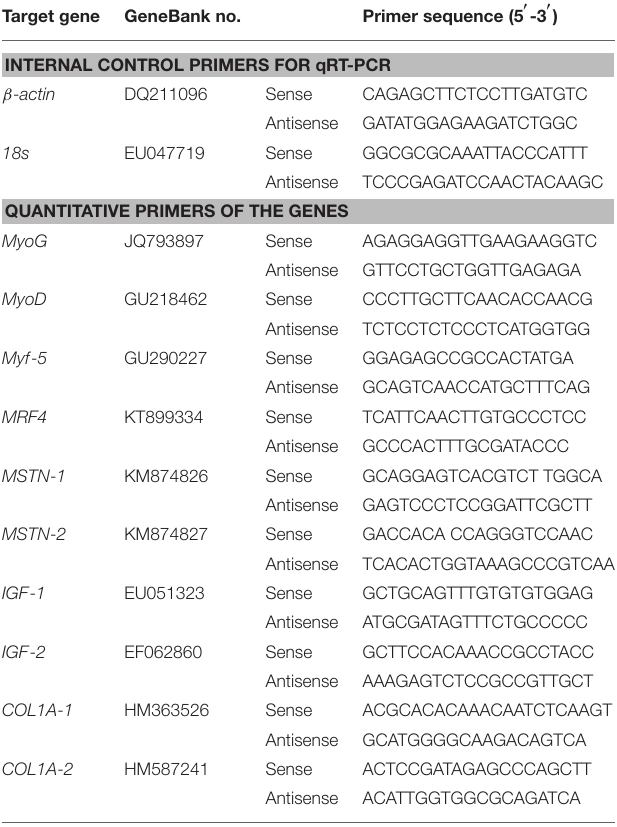
TABLE 1 | The primer sequences for genes cloning and expression in the study. Target gene GeneBank